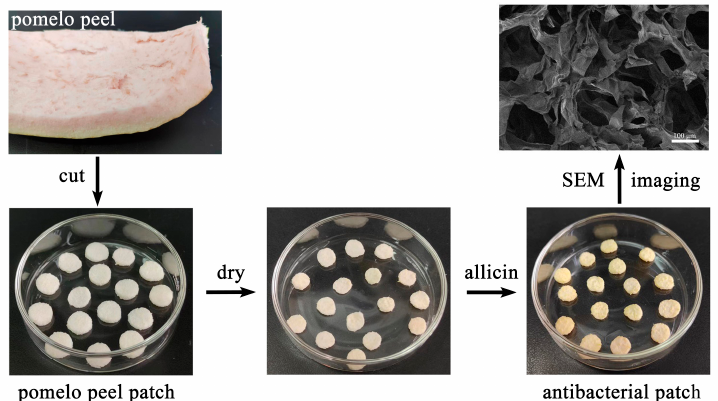
Figure 2. The antibacterial patch preparation processes by using pomelo peel as the scaffold and the extracted allicin as the antibacterial agent.